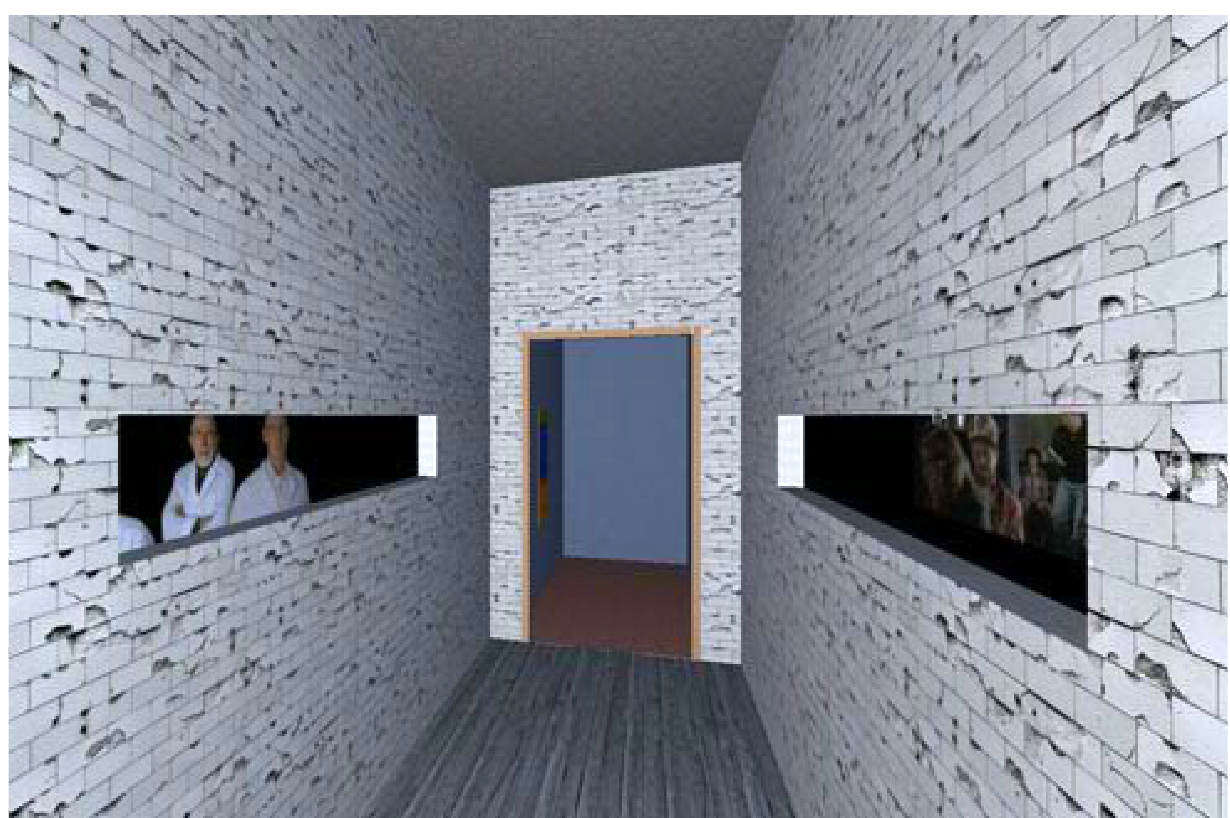
Figure 1. Still from Psychasthenia 1 . Courtesy of the